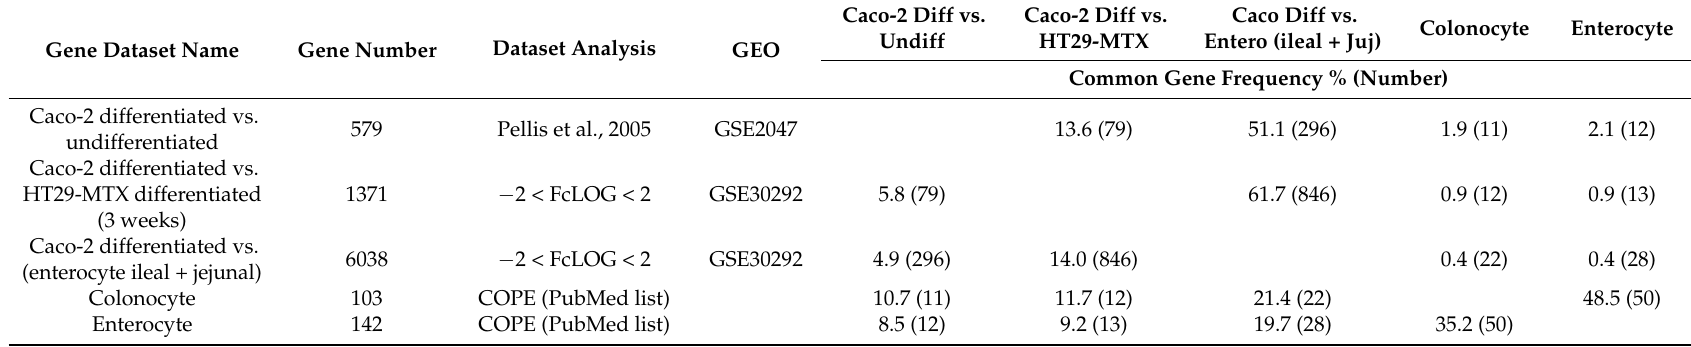
Table 1. Gene datasets used for intestinal phenotype analysis. Datasets were retrieved from Gene Ontology Datasets (GEO) at www.ncbi.nih.gov, raised from fold changes (FcLOG), or published at COPE http://www.copewithcytokines.de/cope.cg. The number of genes commonly found in the 7000 genes analyzed are indicated.